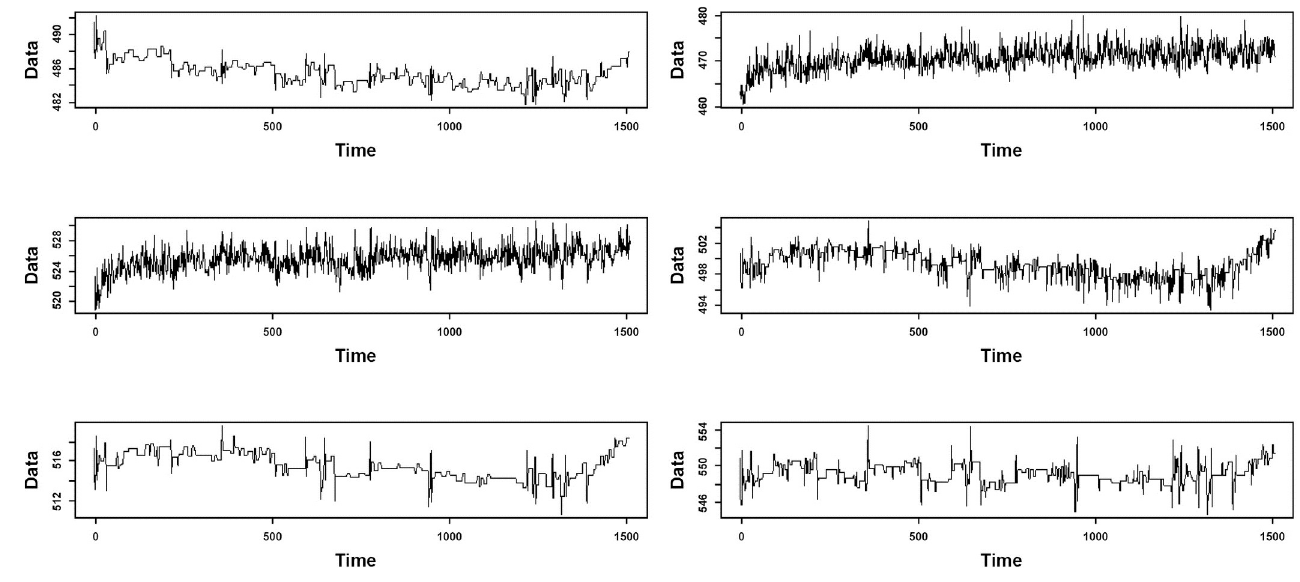
Fig 17. Trends of TET data for normal process. https://doi.org/10.1371/journal.pone.0243146.g017 Fig 18 displays the Q and T 2 of the implemented model for testing fault-free data sets, respec- tively. Fig 19A and 19B reveal the Q and T2 of the faulty data. Fig 18 reveals the monitoring performance of MWDPCA for TET data’s normal process. All the samples are under the control limits. The fault index is 0, meaning that FAR index is zero. Fig 19A illustrates that the process is working in its normal situation, where the observa- tions under the control limits and fault index are zero, and then suddenly, a step change occurs. The fault index switches to one which explains the change in the process situation.